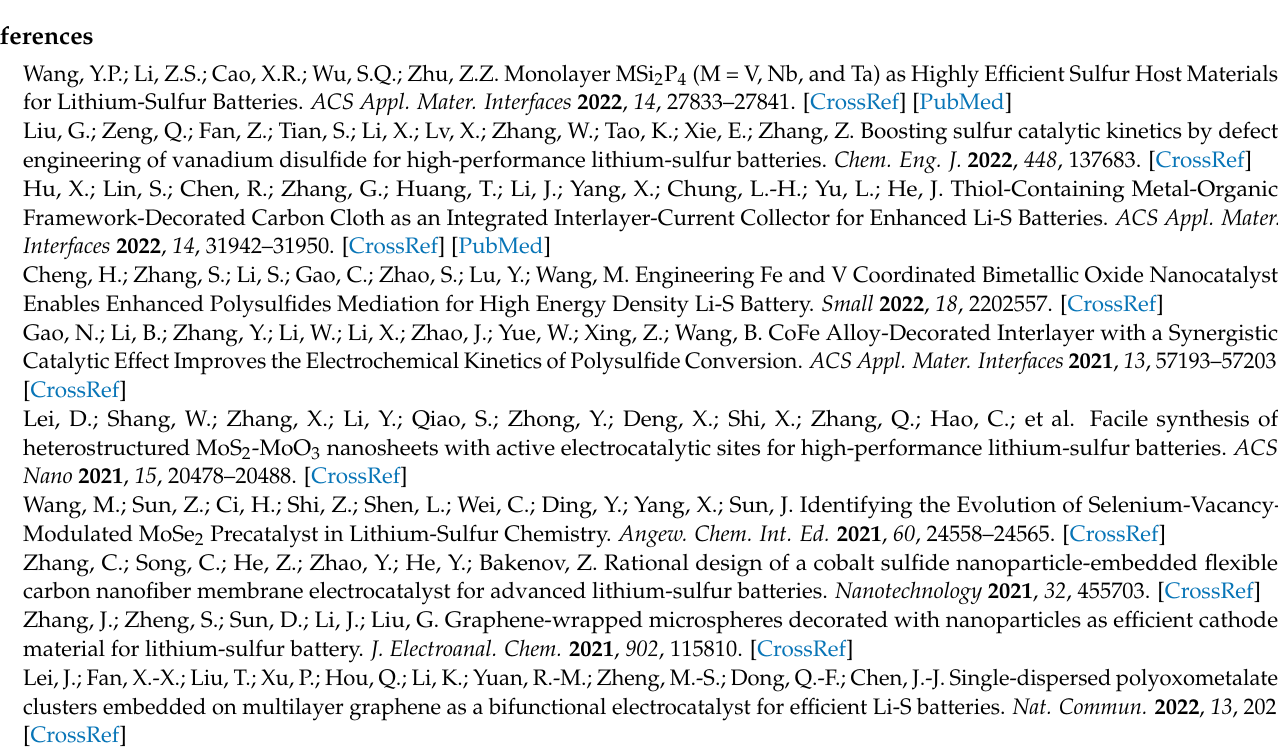
mapping of Ni-NiS/NCF. Figure S2: High resolution Ni 2P XPS spectrum of Ni-NiS/NCF after adsorbing Li 2 S 6 . Figure S3: CV curves of the symmetric cell assembled with Ni-NiS/NCF at different sweep speeds. Figure S4: The alternating-current impedance spectrum of the cells with different coated separators. Figure S5: The charge and discharge curves of the cells with different coated separators at different rates. (a) Ni-NiS/NCF (b) NiS/NCF (c) NiS/NCF. Figure S6: At 0.5 C, after 100 cycles, the picture of lithium anode: (a) Ni-NiS/NCF; (c) NiS/NCF; (e) Ni/NCF. SEM image of lithium anode surface: (b) Ni-NiS/NCF; (d) NiS/NCF; (f)